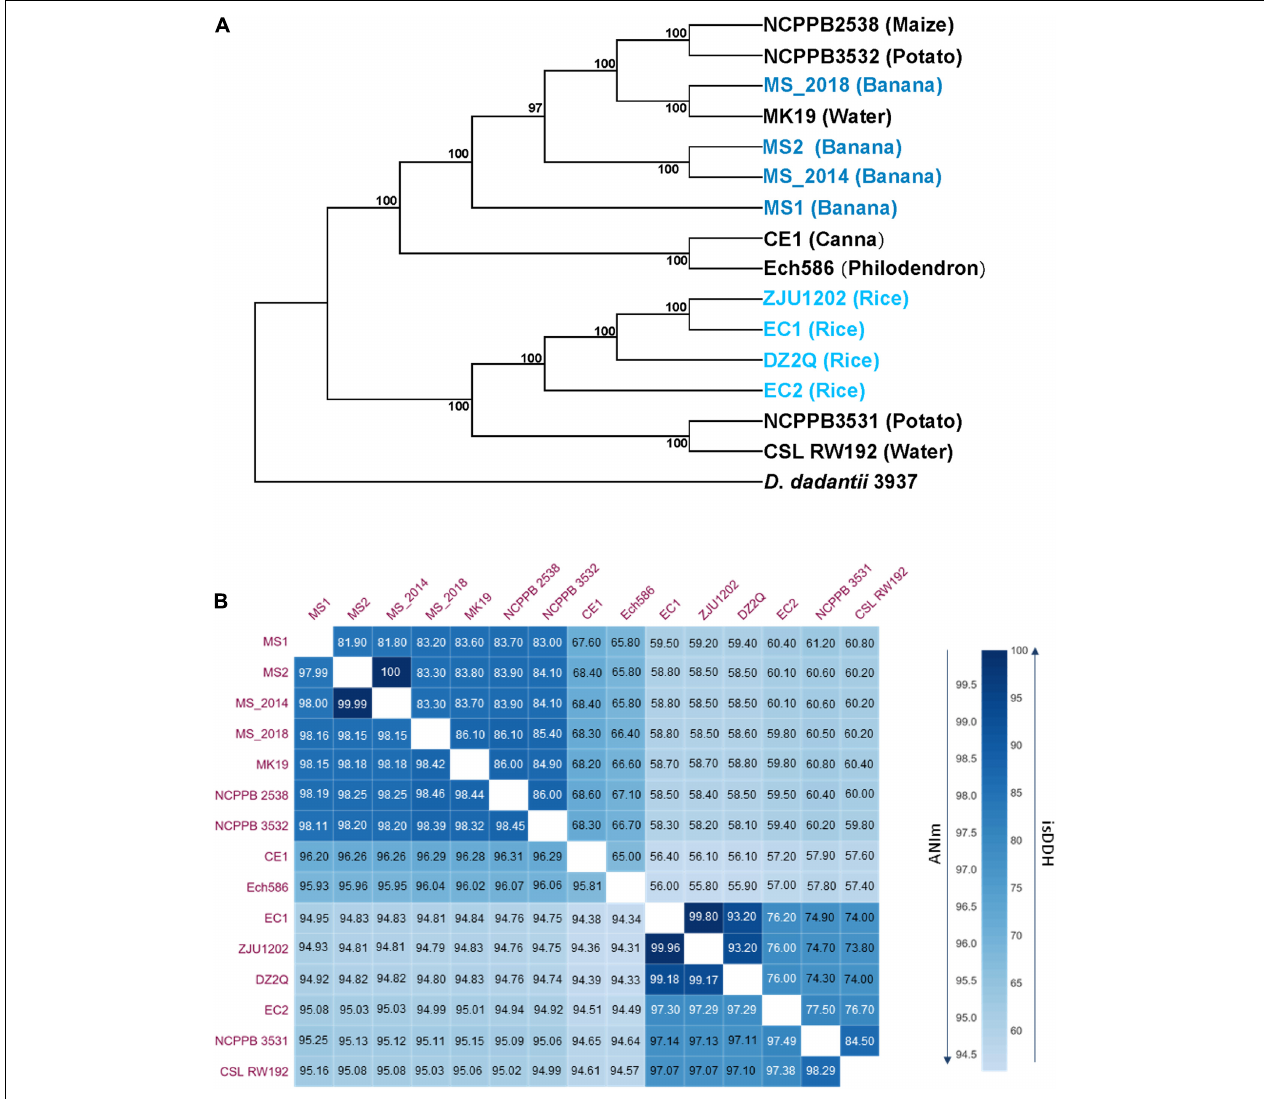
FIGURE 2 | Phylogenetic, average nucleotide identity (ANI) and in silico DNA–DNA hybridization (isDDH) analyses of D . zeae strains based on genome sequences. (A) Phylogenetic analysis was conducted with the maximum likelihood method and bootstrapped at 1,000 replications, and D . dadantii 3937 was used as the out-group control. (B) Calculation of ANI and is DDH between pairs of genome sequences, upper numbers indicate is DDH values and lower numbers indicate the ANI values.